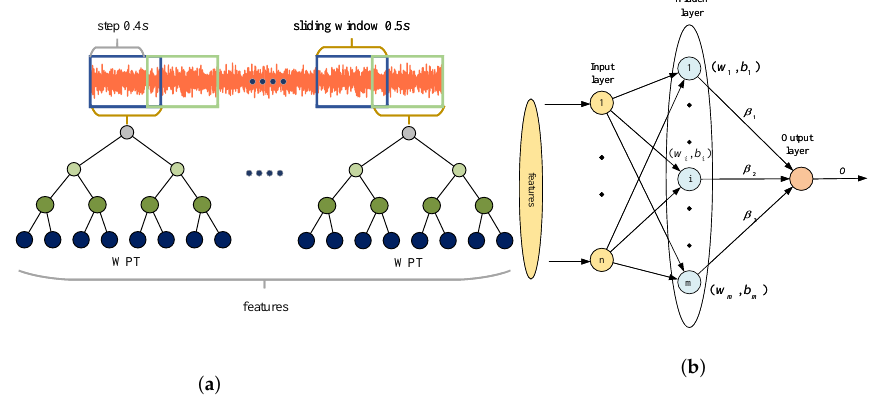
Figure 4. ( a ) Sliding-window based feature extraction; ( b ) structure of